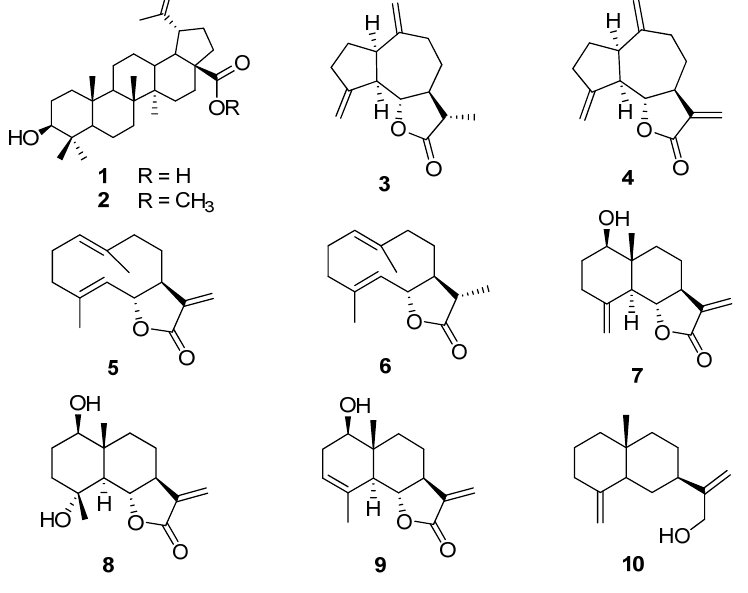
Figure 1. Chemical structures of compounds isolated from the roots of S. lappa.